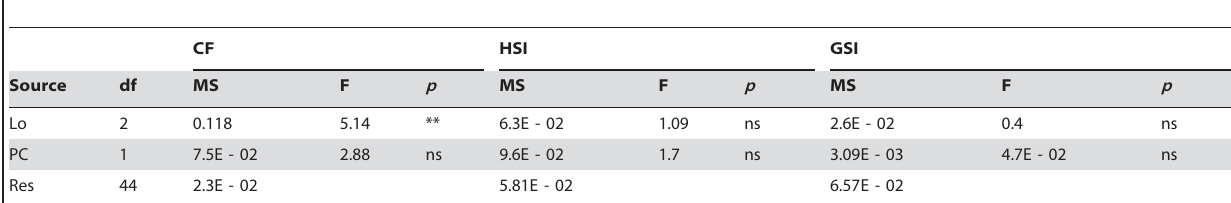
Table 3. PERMANOVA testing differences in general condition markers of fish population among locations and between invaded (TG and BR) vs . non-invaded locations (PC).